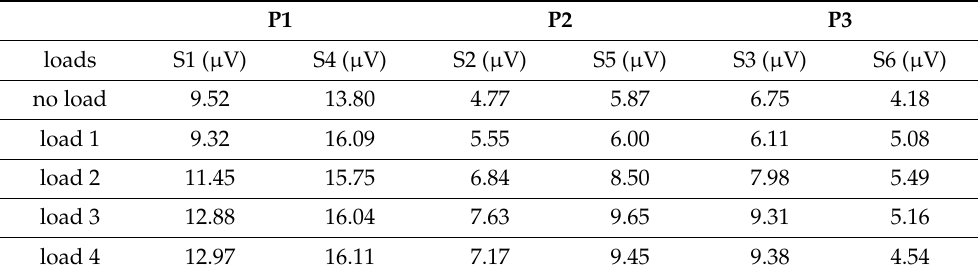
Table 2. Example of measurements obtained from three positions for the faulty machine (A–3A).